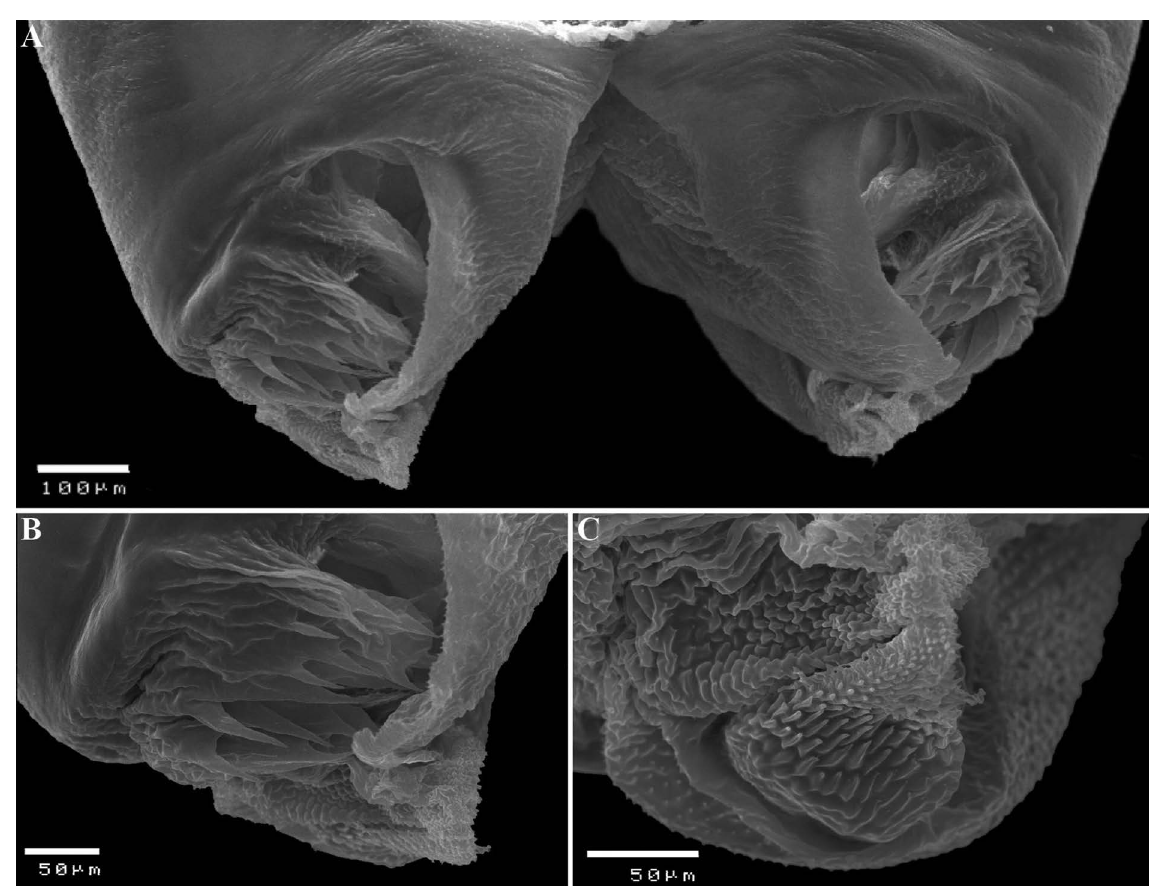
Fig. 59. Charinus diamantinus sp. nov. (MNRJ 9189), male gonopod. A . Gonopod with long and curved lamina medialis (LaM), ventral view. B . Sinistral side of gonopod showing lobus lateralis 2 (LoL2). C . Dorsal